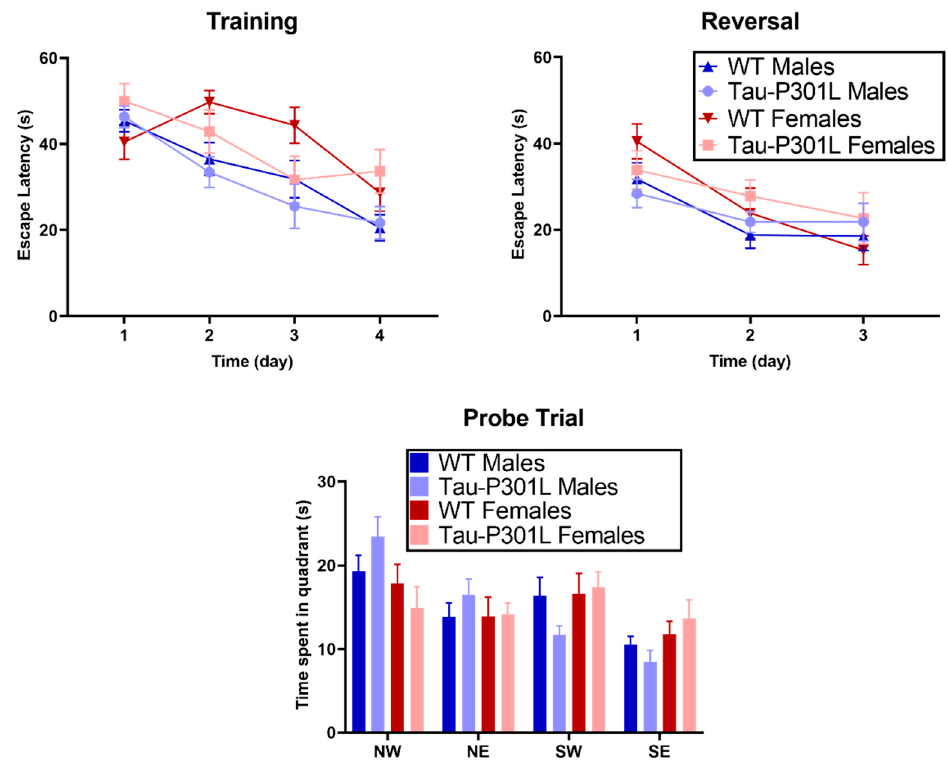
Figure 6. Tau-P301L mice did not have any deficits in the Morris Water Maze (MWM). Tau-P301L and WT mice were evaluated at 8 months of age. In the training and reversal test, both Tau-P301L mice (males: n = 12; females: n = 7) and WT mice (males: n = 12; females: n = 7) spent a similar amount of time to find the platform throughout the days. In the probe trial, both Tau-P301L mice and WT male mice explored the target quadrant similarly (NW). Mixed effect and two-way ANOVA were used for analysis, respectively. Data are given as mean ± SEM.